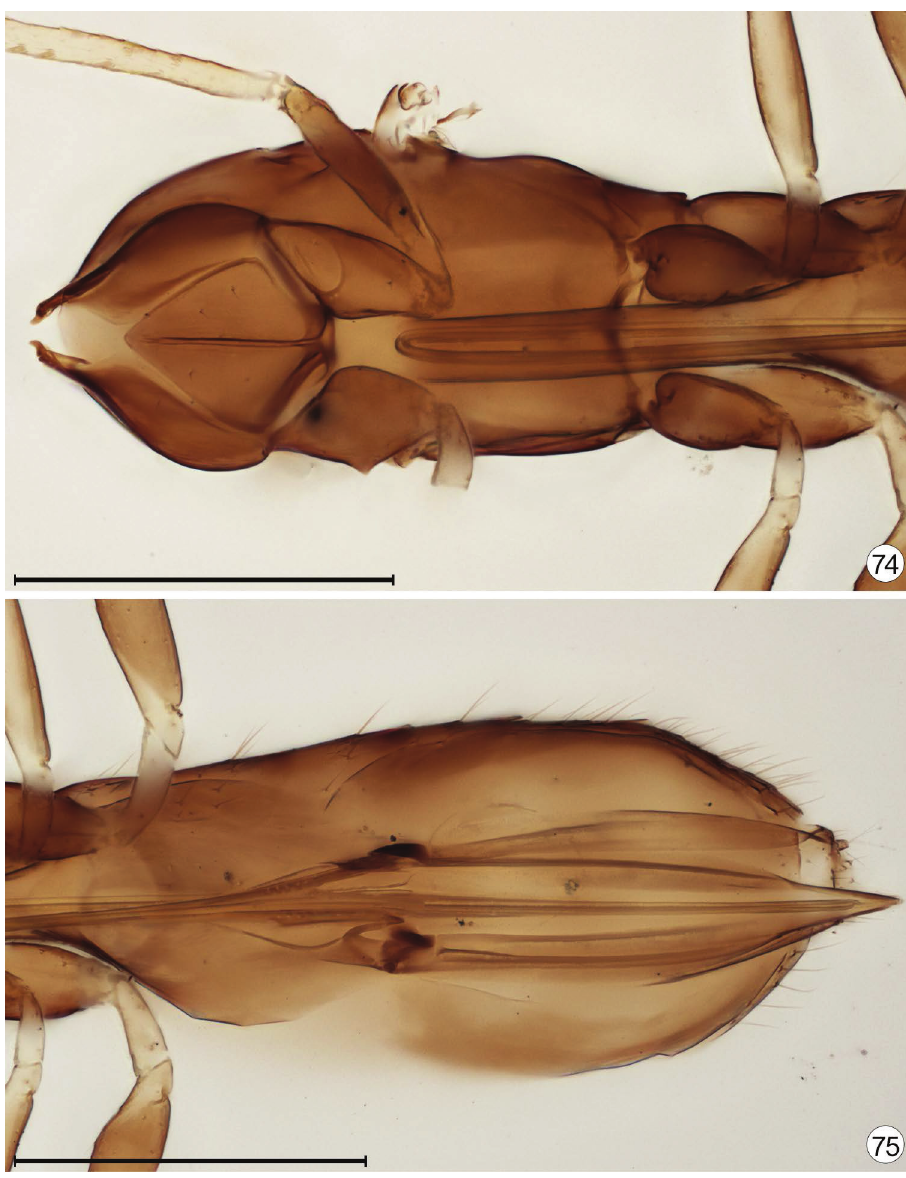
Figures 74, 75. Neotriadomerus burwelli , holotype. 74 mesosoma, ventral 75 metasoma, ventral (seen through body). Scale bar = 300